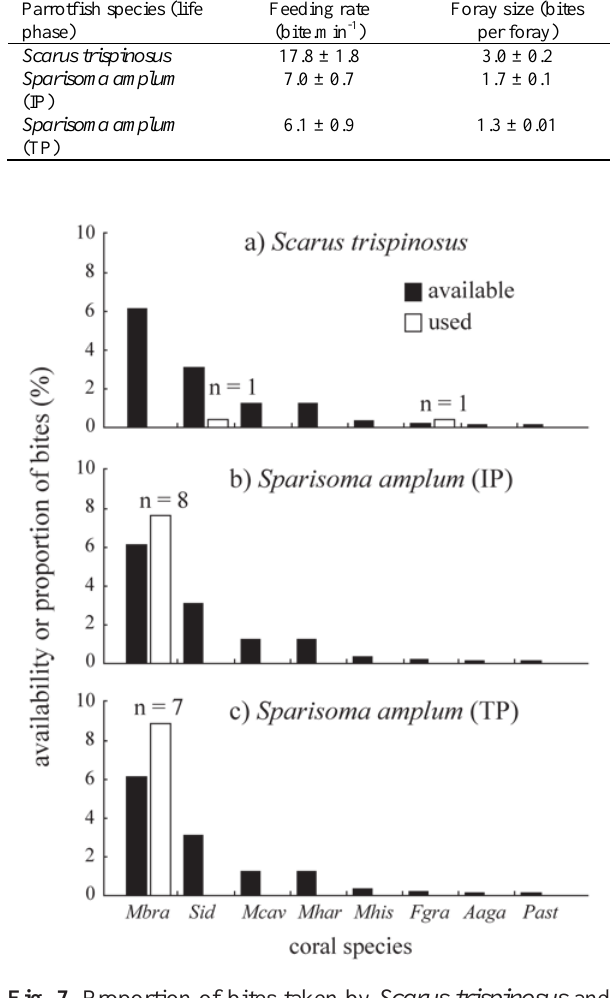
Fig. 7. Proportion of bites taken by Scarus trispinosus and Sparisoma amplum on live corals and availability (%) of dif- ferent coral species. Numbers above bars indicate the abso- lute number of bites taken on each coral species. Coral spe- cies: Mbra – Mussismilia braziliensis ; Sid – Siderastrea spp.; Mcav – Montastrea cavernosa ; Mhar – Mussismilia hartti ; Mhis – Mussismilia hispida ; Fgra – Favia gravida ; Aaga – Agaricia agaricites ; Past – Porites astreoides